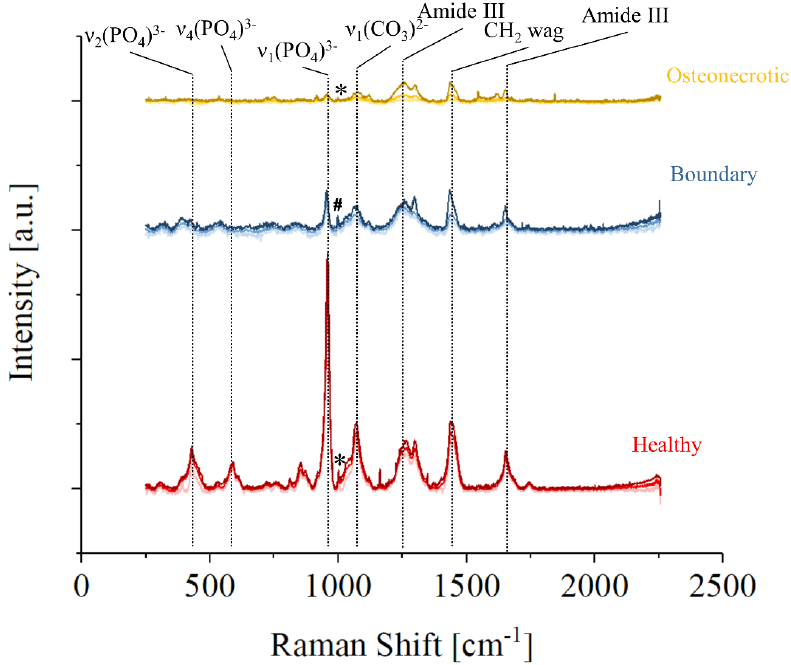
Figure 3. Representative Raman spectra of three different regions of Sample No7: healthy in red, the boundary in blue, and osteonecrotic in yellow. For each set of data, the average spectra and the limits of the 90% confidence interval are presented in different tones. Phenylalanine is marked with an “*” and an unknown band, marked with a “#”, appears at slightly lower Raman Shifts. While the strongest Raman vibration of the osteonecrotic tissue appears to be the Amide III band situated at about 1260 cm − 1 , the average spectrum collected in the bound- ary tissue shows a relatively stronger CH 2 wagging band. Considering the whole region from 1000 to 1750 cm − 1 and associated with collagen and proteins, the strongest Raman intensity was recorded in the boundary regions, which seems to indicate that collagenous tissue is preferentially formed in those areas. A small peak associated with Phenylalanine and marked with an “*” could be clearly observed in the healthy and osteonecrotic bone, but not in the boundary region where an unknown intense band, marked with a “#”, appears at slightly lower Raman Shifts. The graph in Figure 4 shows the relationship between the FWHM of the band at 960 cm − 1 and related to ν 1 (PO 4 ) 3- vibrations in hydroxyapatite, and the intensity ratio between the bands at 960 cm − 1 vs. three regions: 1243–1269 cm − 1 , representing Amide III vibrations, 1450 cm − 1 representing CH 2 wagging, and 1660 cm − 1 for Amide I vibrations. Necrotic tis- sues are marked with a circle, boundary regions with a square, and healthy bone refer- ences with a triangle. Each symbol represents the average of about 1500 spectra, with the statistical dispersion omitted for clarity. For reference, the dispersion for necrotic tissue is in usually the range of ±22% of the average value, and it reduces to about ±10% for the healthy tissue. Even if the data is highly scattered, which is a common occurrence when analyzing biological samples coming from different donors, osteonecrotic tissues tend to have a lower ratio (x-axis) and a more scattered FWHM (y-axis) when compared to their healthy counterparts.